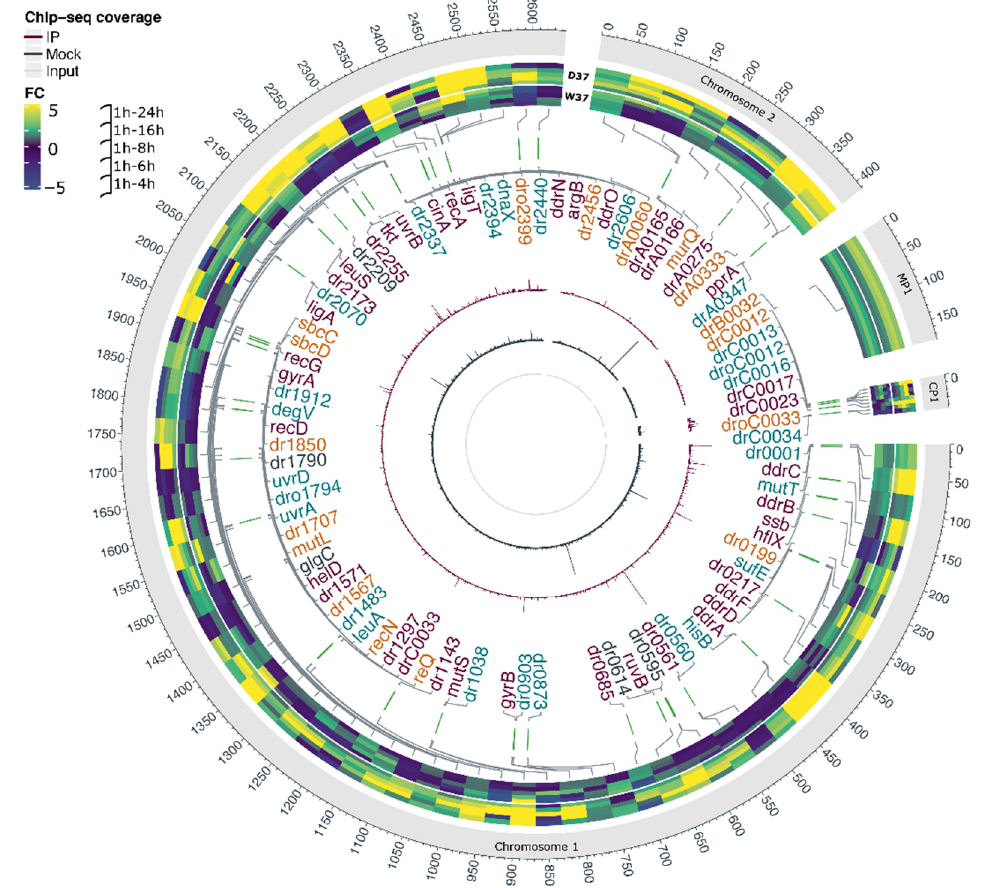
Figure 7. Representation of identified DdrO target genes across the D. radiodurans genome. Each genome replicon is represented by an outer circle. Heatmaps represent Fold Change values for the 85 genes, sometimes in operons, matching with at least two of the selected criteria (see Figure 1). The genomic positions of deregulated genes are drawn in grey connections. The DdrO bound sites associated with identified candidate genes included in the DdrO regulon are illustrated by green vertical lines. High confidence DdrO targets genes matching with three criteria are indicated in purple. The other genes matching with two criteria are labeled in dark gray (ChIP-seq and Transcriptomics), blue (Transcriptomics and RDRM), or orange (ChIP-seq and RDRM). The purple circle shows the mean coverage from the three IP replicates. The dark grey circle shows Input tag density profiles and the light grey shows the Mock tag density profiles.